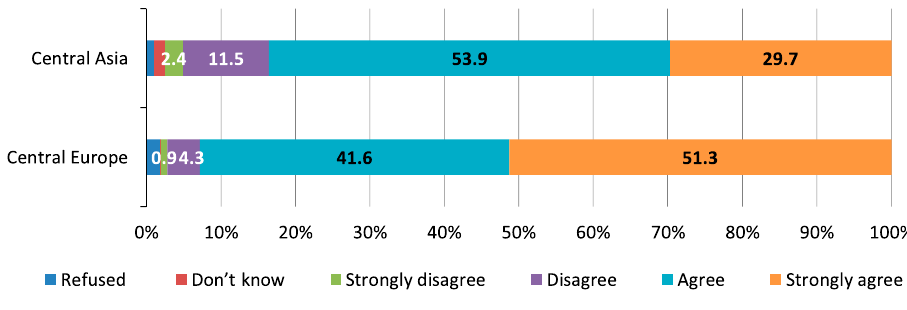
Figure 1. Descriptive statistics of women’s agreement with the statement by region